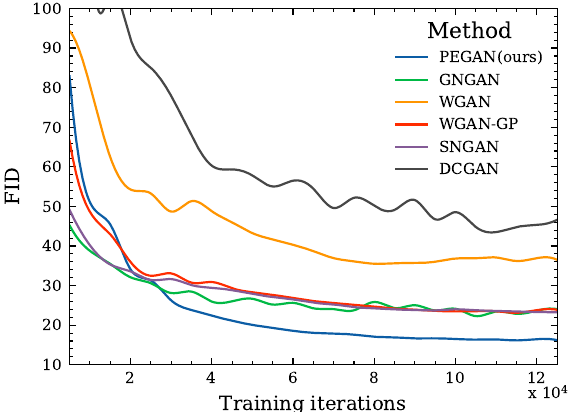
Figure 5. Learning curves of FID for different methods on CIFAR-10 (over